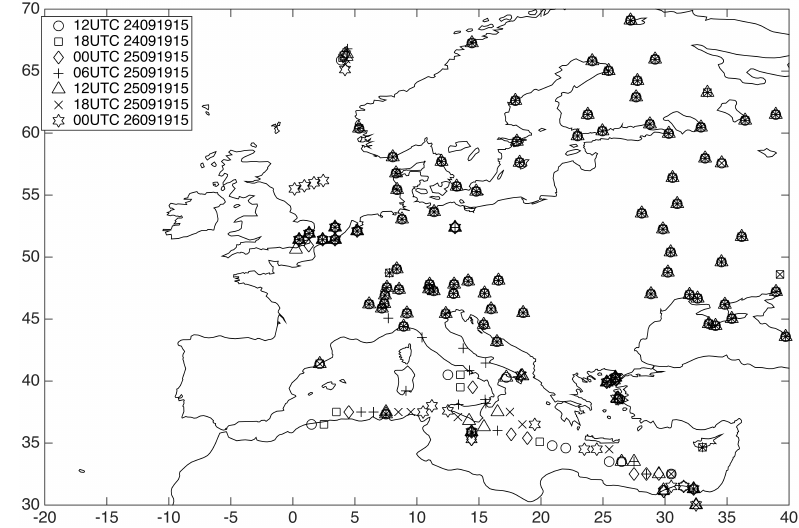
Figure 12. Surface pressure stations assimilated every 6h in the period 12:00UTC 24 September 1915–00:00UTC 26 September 1915.